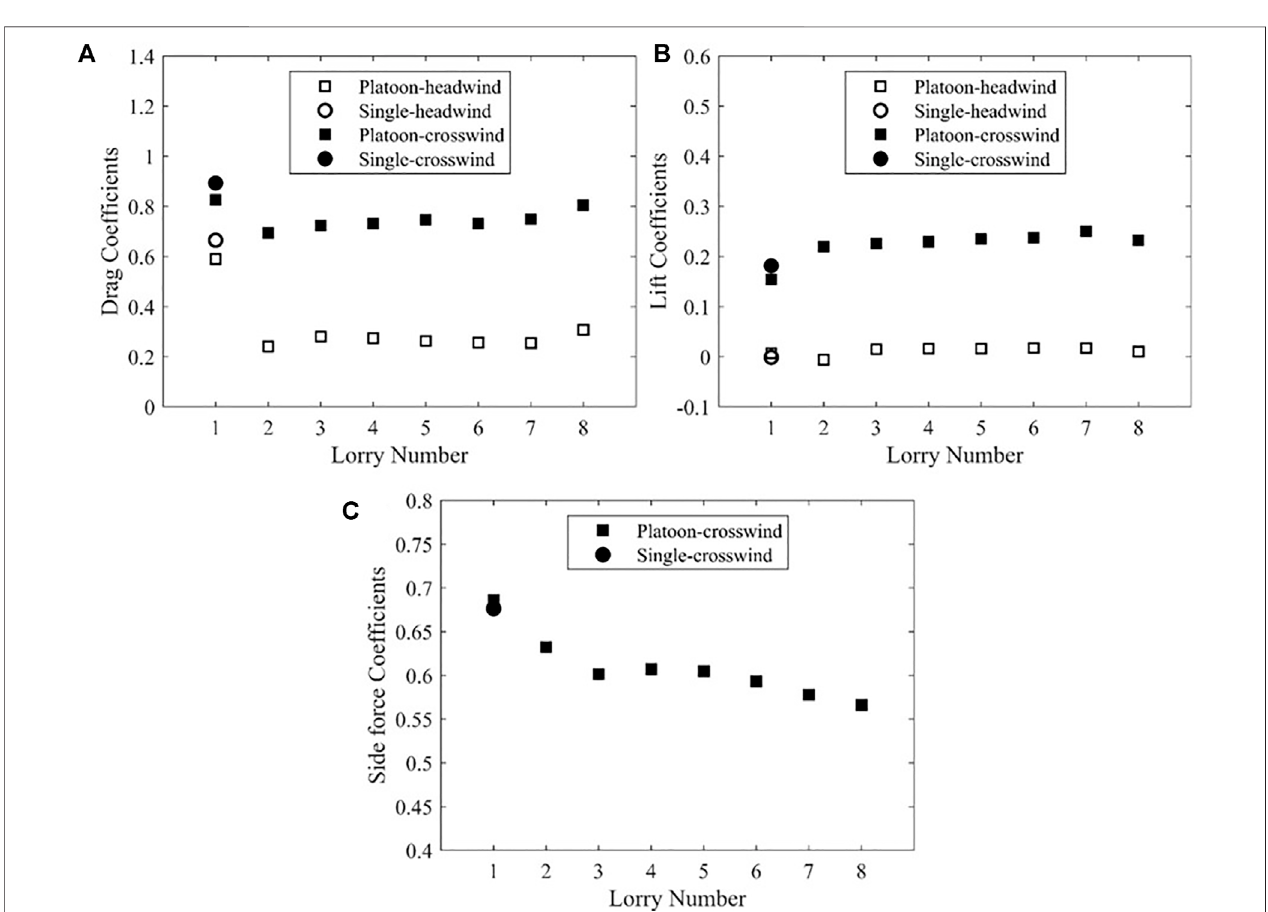
FIGURE 5 | The aerodynamic coef fi cients obtained from the current study and He et al. (2019). (A) . drag coef fi cients; (B) . lift coef fi cients; (C) . side coef fi cients.